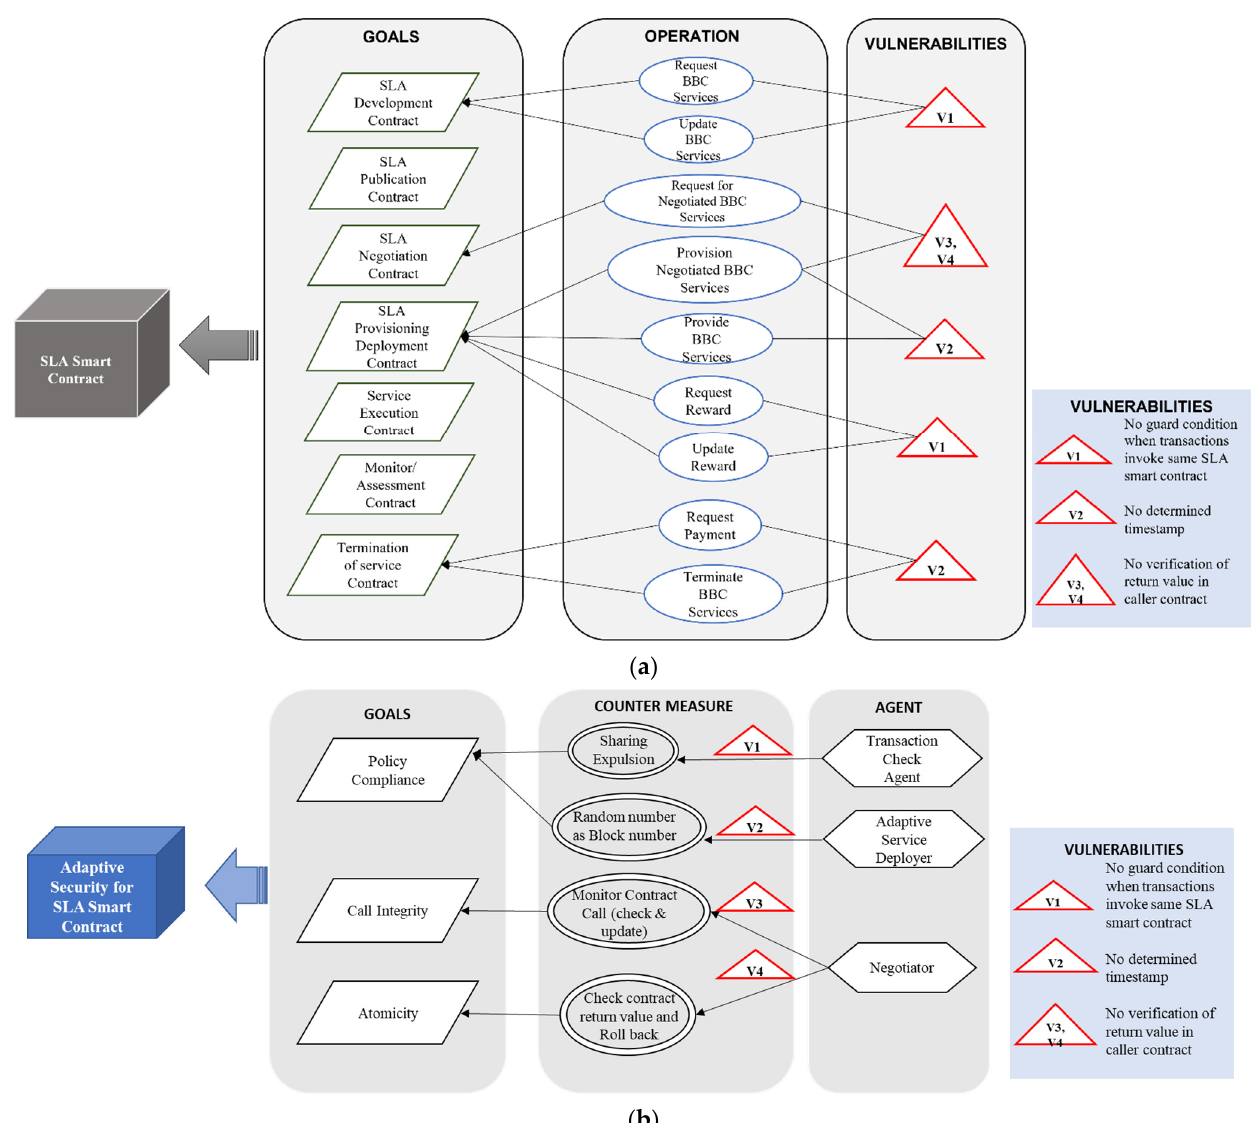
Figure 4. ( a ) Goal model for SLA smart contract. ( b ) Adaptive security goal model for SLA smart contract.